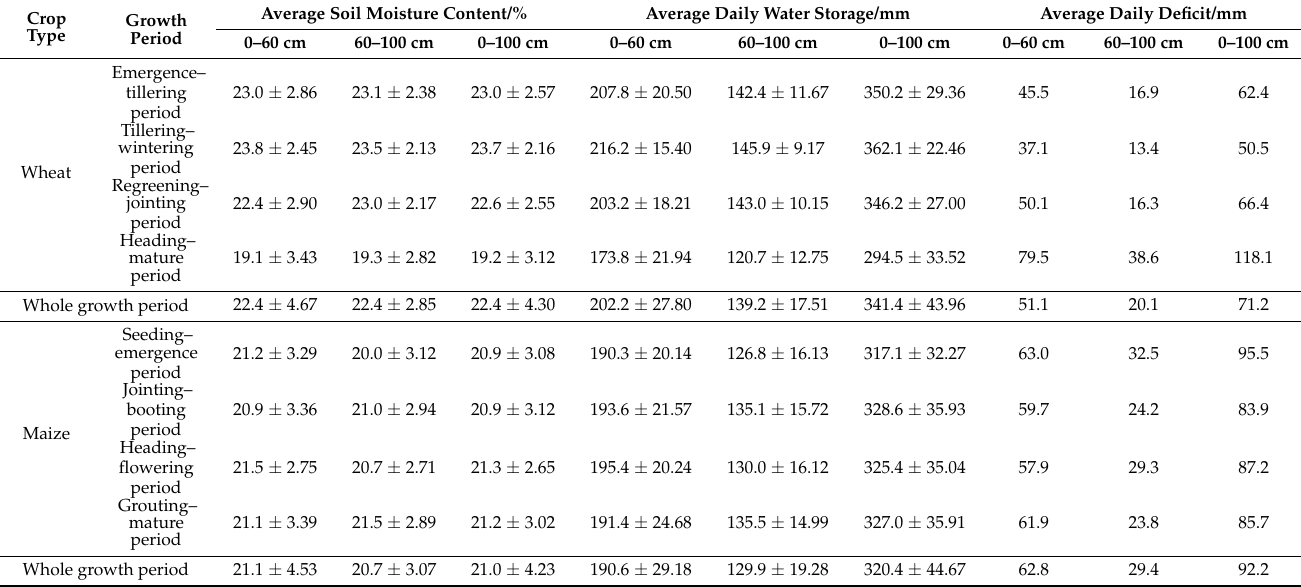
Table 4. Soil moisture status during different growing